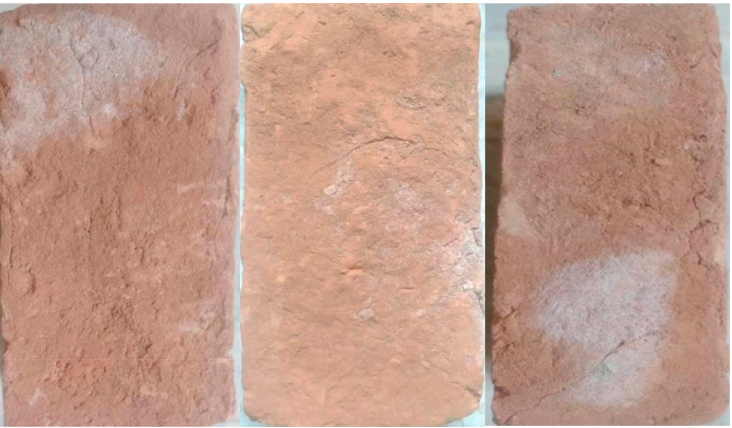
Figure 8. The effect of